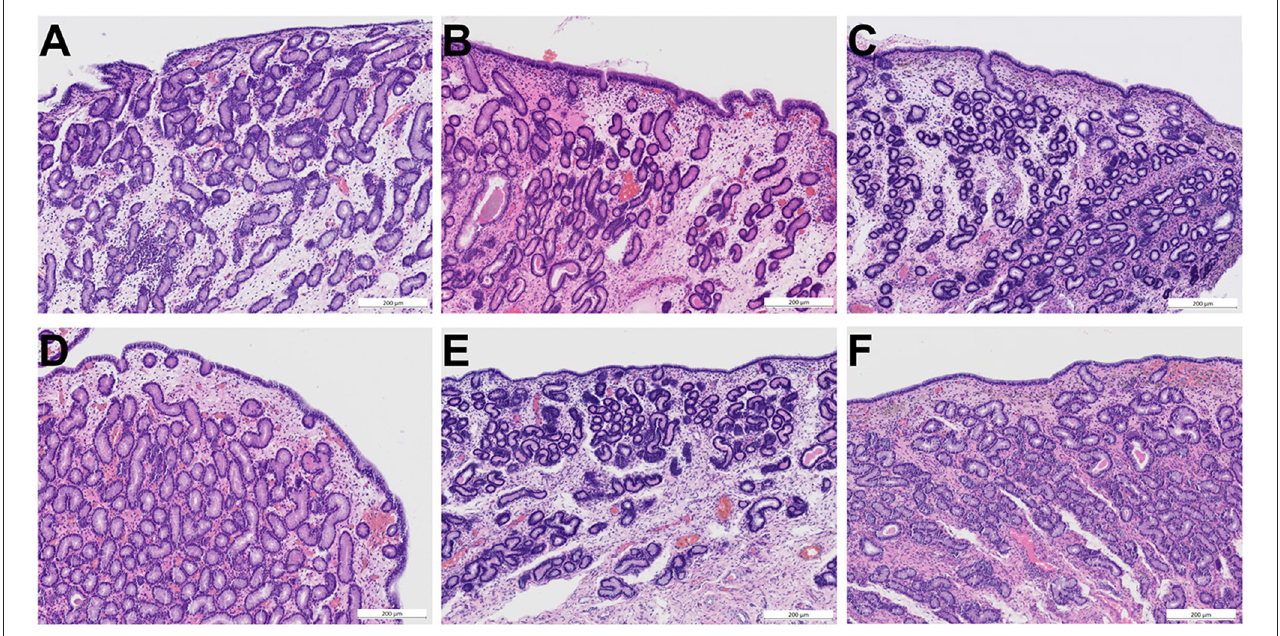
FIGURE5 Photomicrographs (HE staining) of endometrial biopsies obtained before treatment (A–C) and after treatment (D–F) . (A) Endometrium of mare 3 before treatment with ozone (age 12, category III, moderate signs of endometritis). (B) Endometrium of mare 15 before treatment with trimethoprim-sulfadimethoxine (age 10, category III, moderate signs of endometritis). (C) Endometrium of mare 22 before treatment with air (age 9, category III, mild signs of endometritis). (D) Endometrium of mare 3 after intrauterine insufflation of ozone showing mild signs of endometritis and an intact surface epithelium. (E) Endometrium of mare 15 after systemic treatment with trimethoprim-sulfadimethoxine showing mild signs of endometritis and an intact surface epithelium. (F) Endometrium of mare 22 after intrauterine insufflation of air showing mild signs of endometritis and an intact surface epithelium. Scale bars = 200 µ m. All categories according to Kenney and Doig (26), modified by Schoon et al.